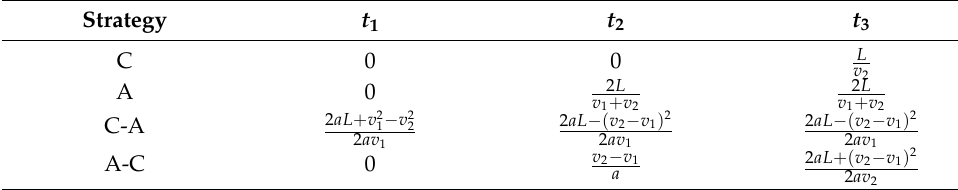
Table 1. Analytical parameterization of t 1 , t 2 , and t 3 for each strategy.